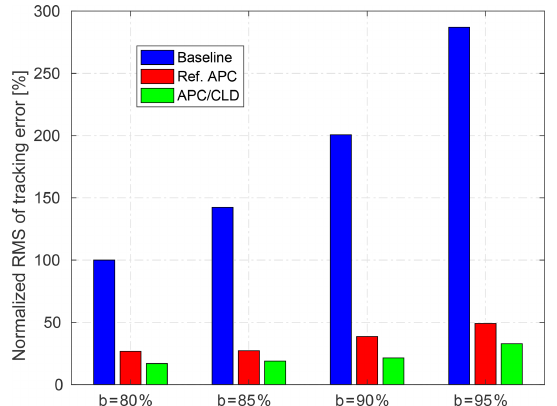
Figure 19. Normalized root mean square (RMS) of wind farm power-tracking error for different levels of AGC power refer- = 12 . 3MW, b = 80%, 85%, ence (Eq. 23), parameterized as P base farm 90%, 95%, respectively, and c = 10%. The baseline case with power demand level b = 80% is considered the